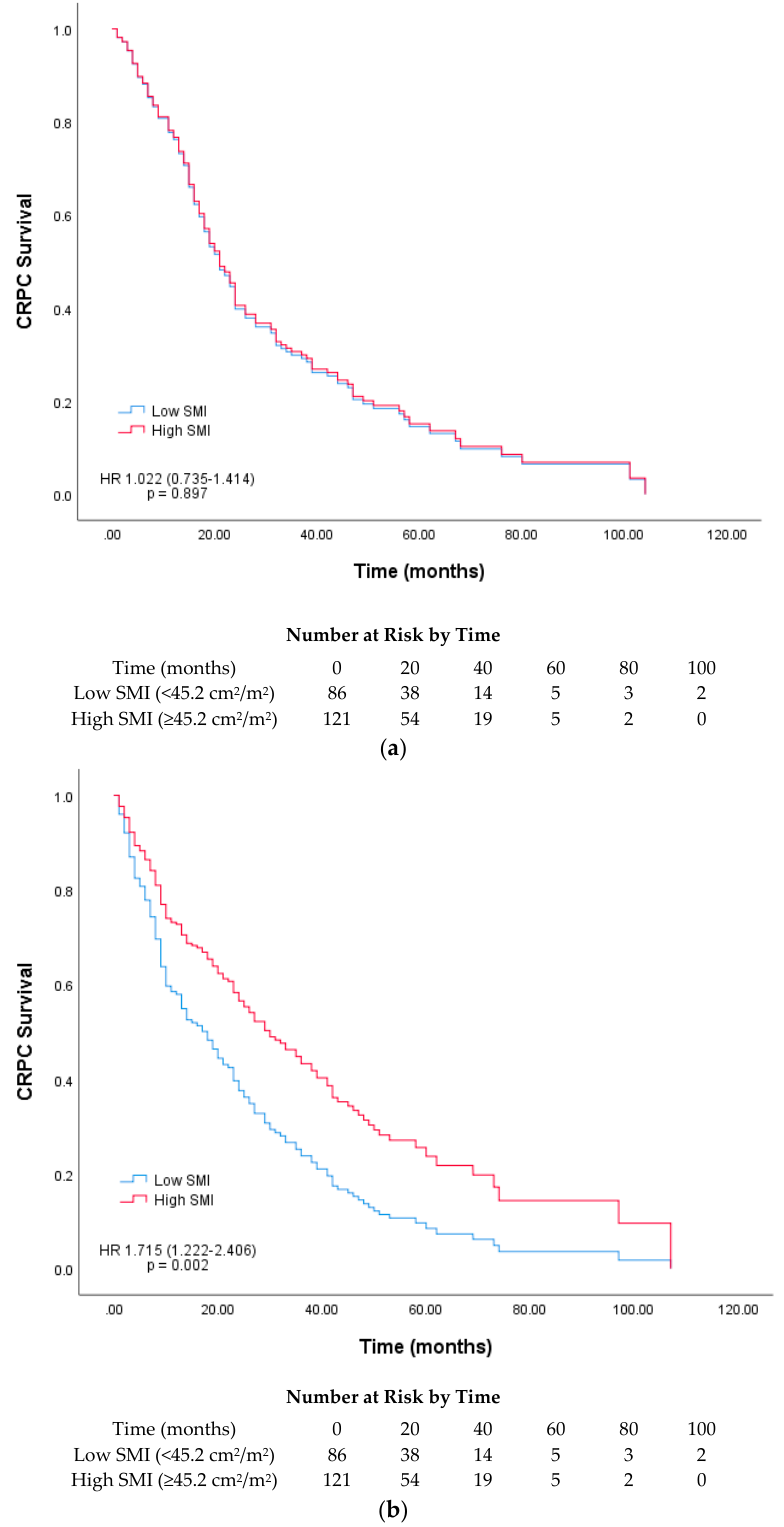
Figure 3. Survival plot based on Cox regression analysis of castration-resistant prostate cancer (CRPC) survival according to the median skeletal muscle index (SMI; cm 2 /m 2 ) for the age groups ( a ) <70 and ( b ) >70 years at CRPC diagnosis.